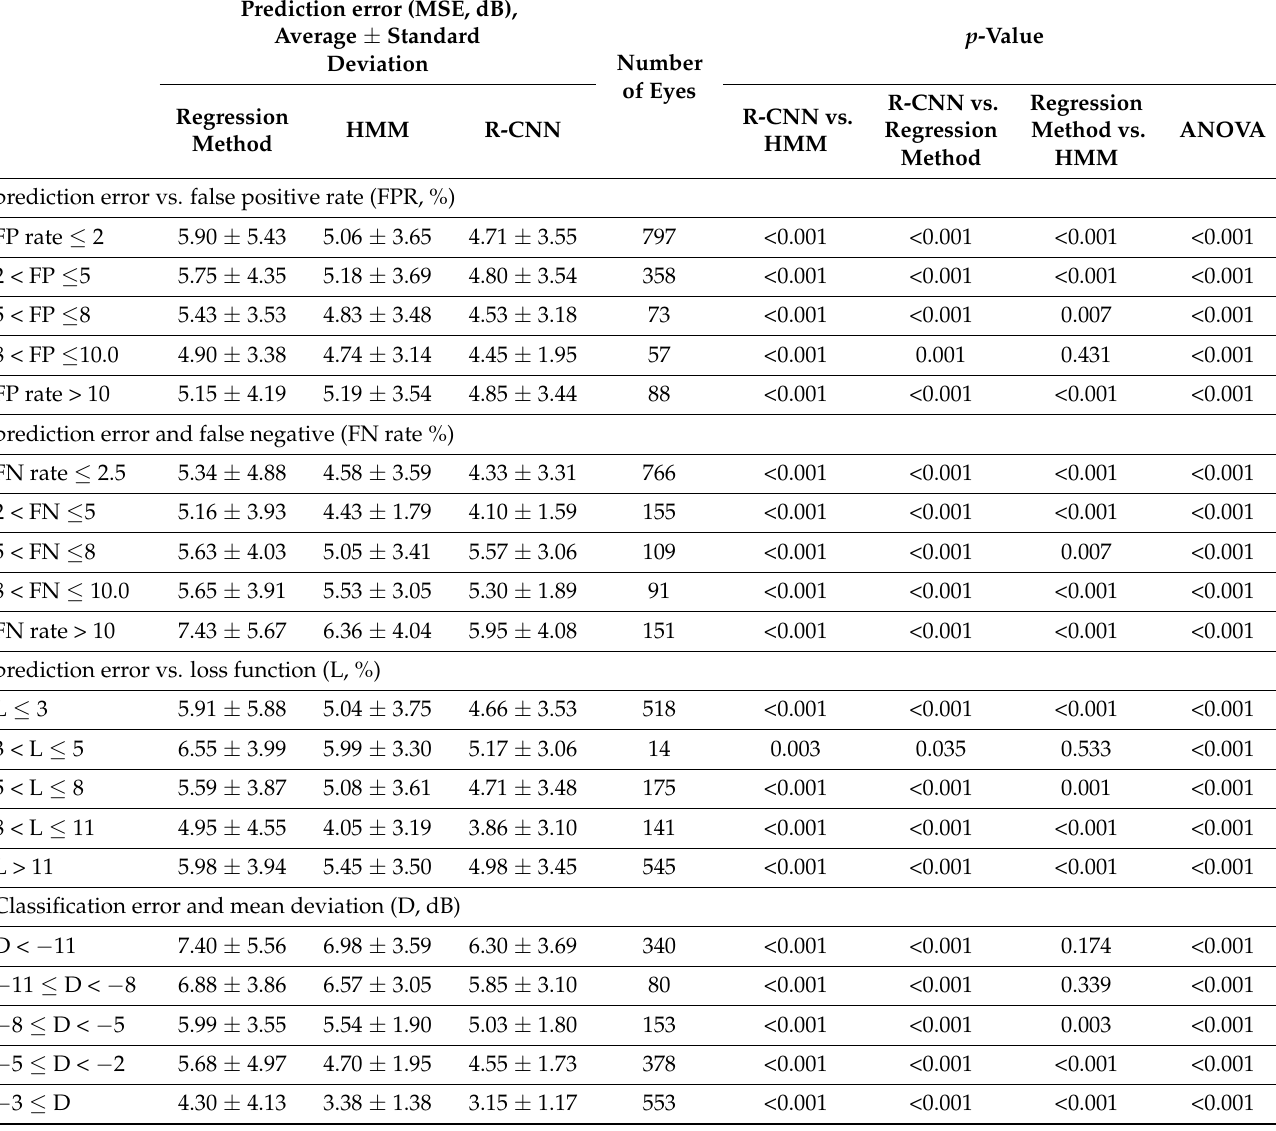
Table 11. Mean classification error (MSE) according to reliability